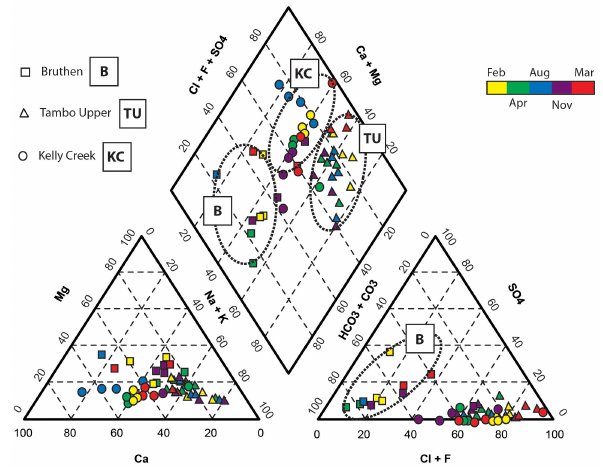
Figure 5. Piper plot of bank water from the Tambo River. Black markers – HCO 3 measured; grey and white markers – HCO 3 calcu- lated via charge balance.